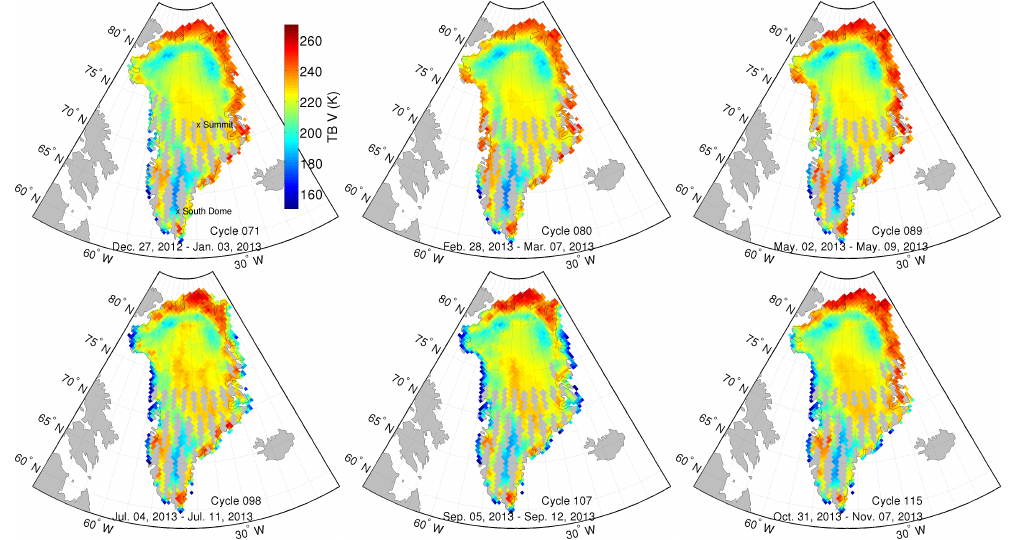
Fig. 1. Maps of TB (radiometer 3) at V polarization (in K) over the GIS every two months in 2013. Grid cells with land fraction less than 0.25 were masked.